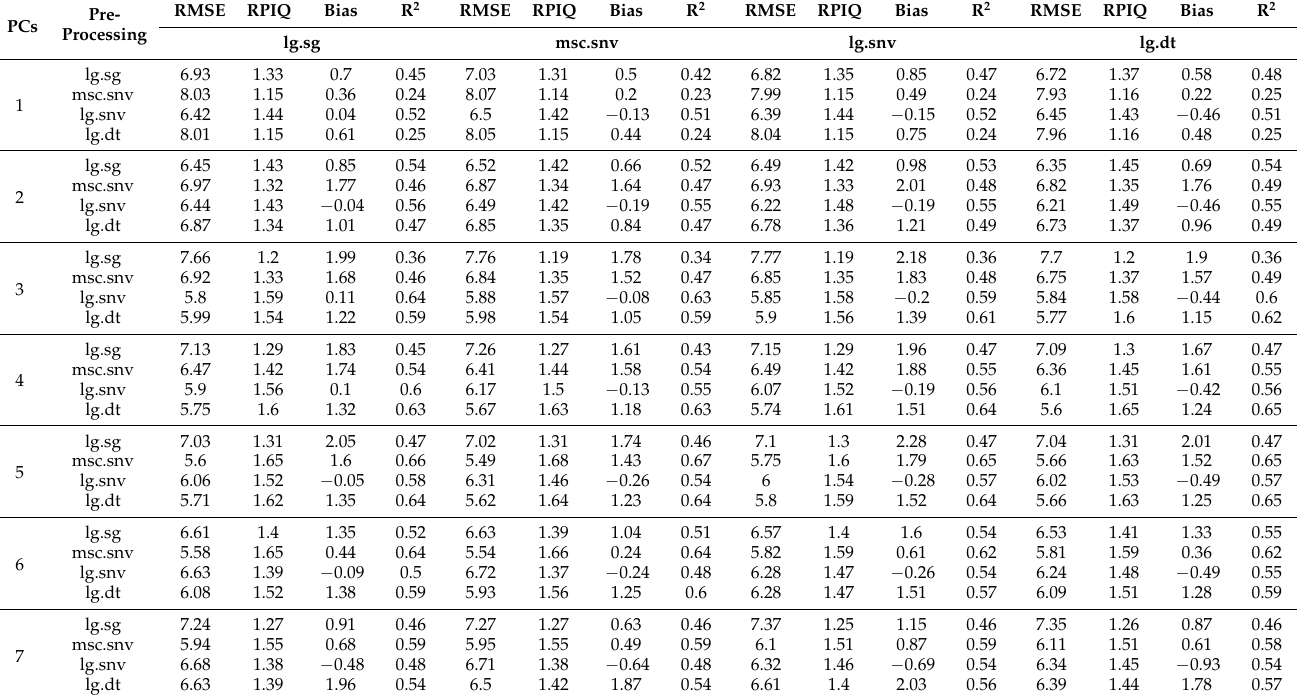
Table 4. The statistics of prediction results of kriging for SOM using different principal numbers under different preprocessing